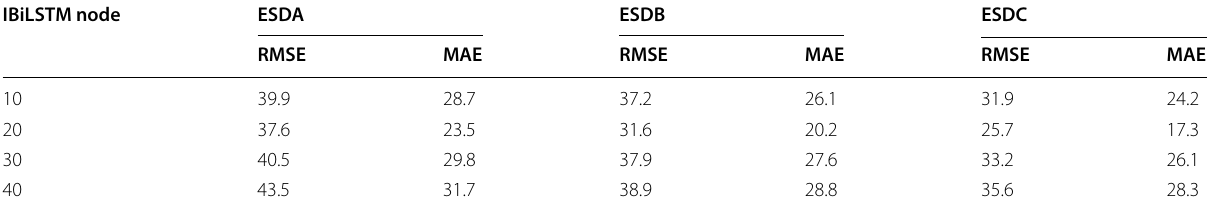
Table 7 Analysis on IBiLSTM node IBiLSTM